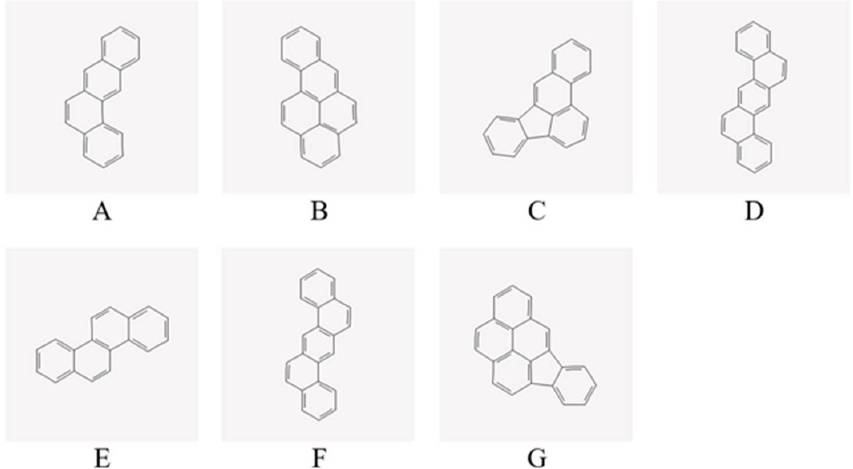
Figure 2. Molecular structures of the seven probable human carcinogens categorized by the